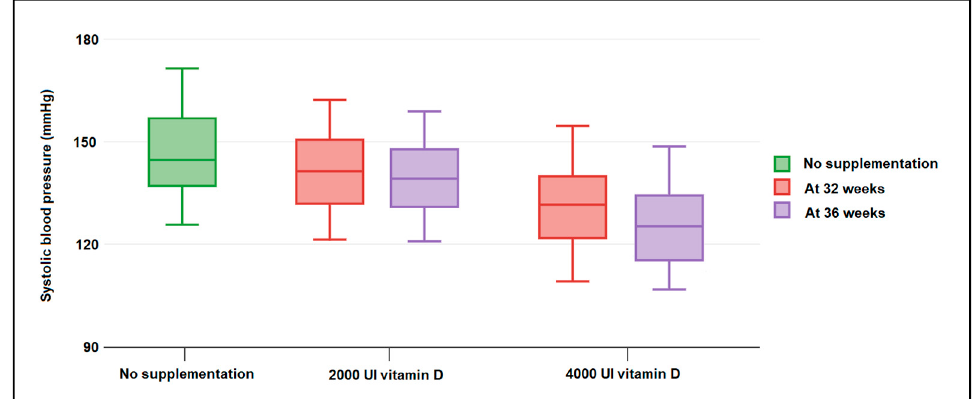
Figure 2. Boxplot of maternal systolic blood pressure (mm Hg) measured at 32 and 36 weeks of gestation and stratified by nutritional supplementation with 2000 UI and 4000 UI of vitamin D. Data analyzed by Kruskal–Wallis test.